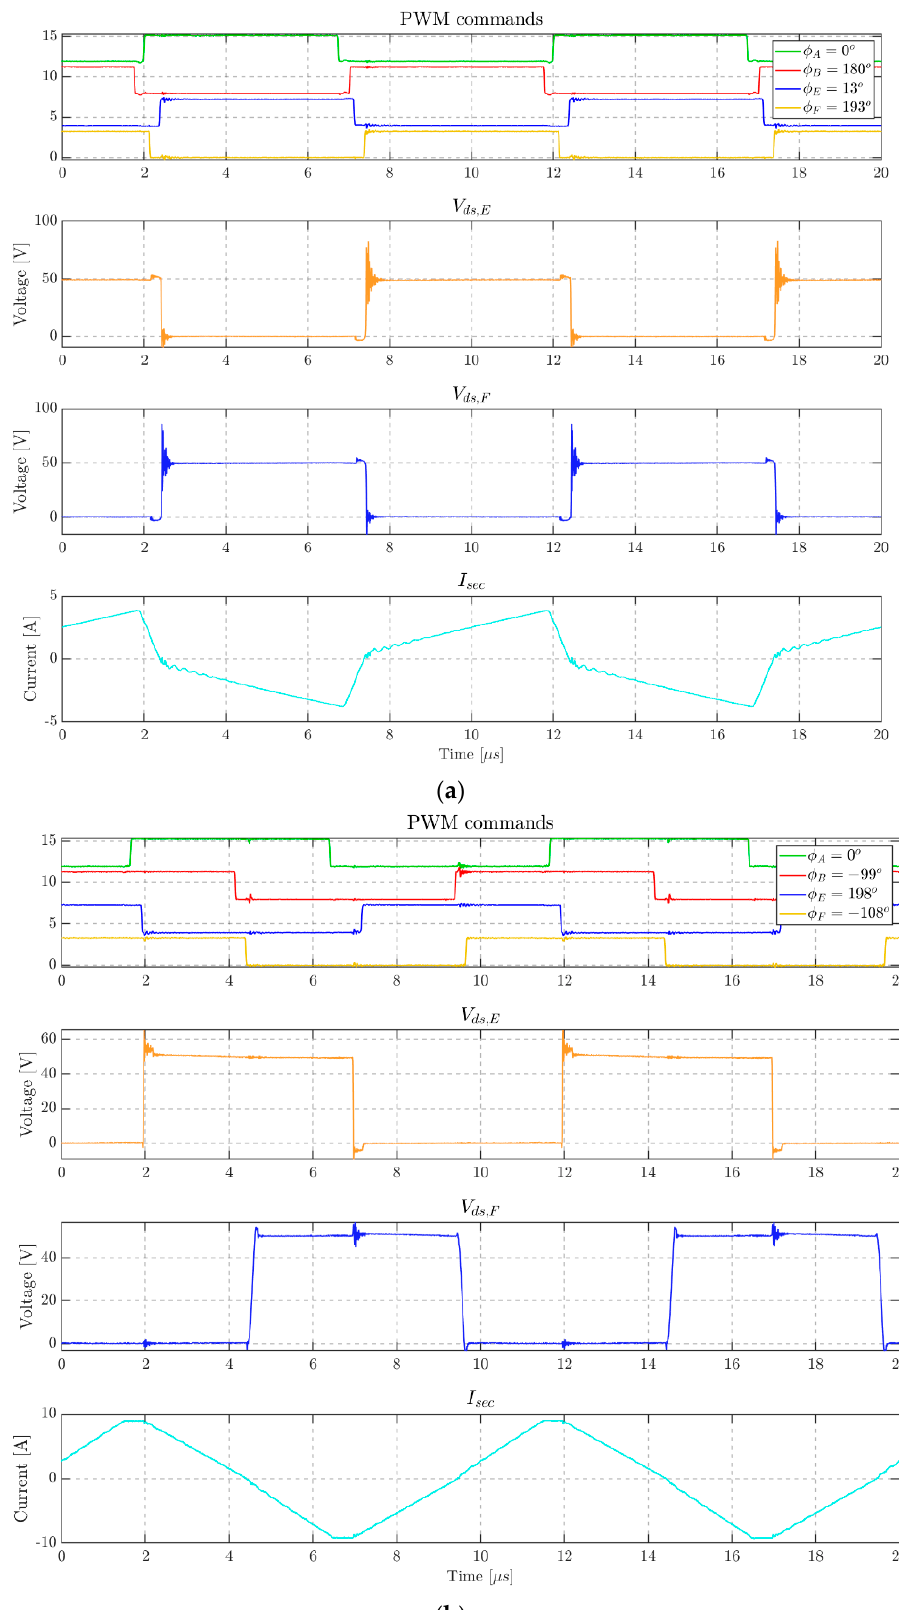
Figure 20. Comparison between SPS control and optimized modulation; both the controls reach the same operating point: ( a ) SPS control, the secondary switches do not reach the ZVS condition; ( b ) arbitrary (optimized) control, all the legs reach the ZVS condition.